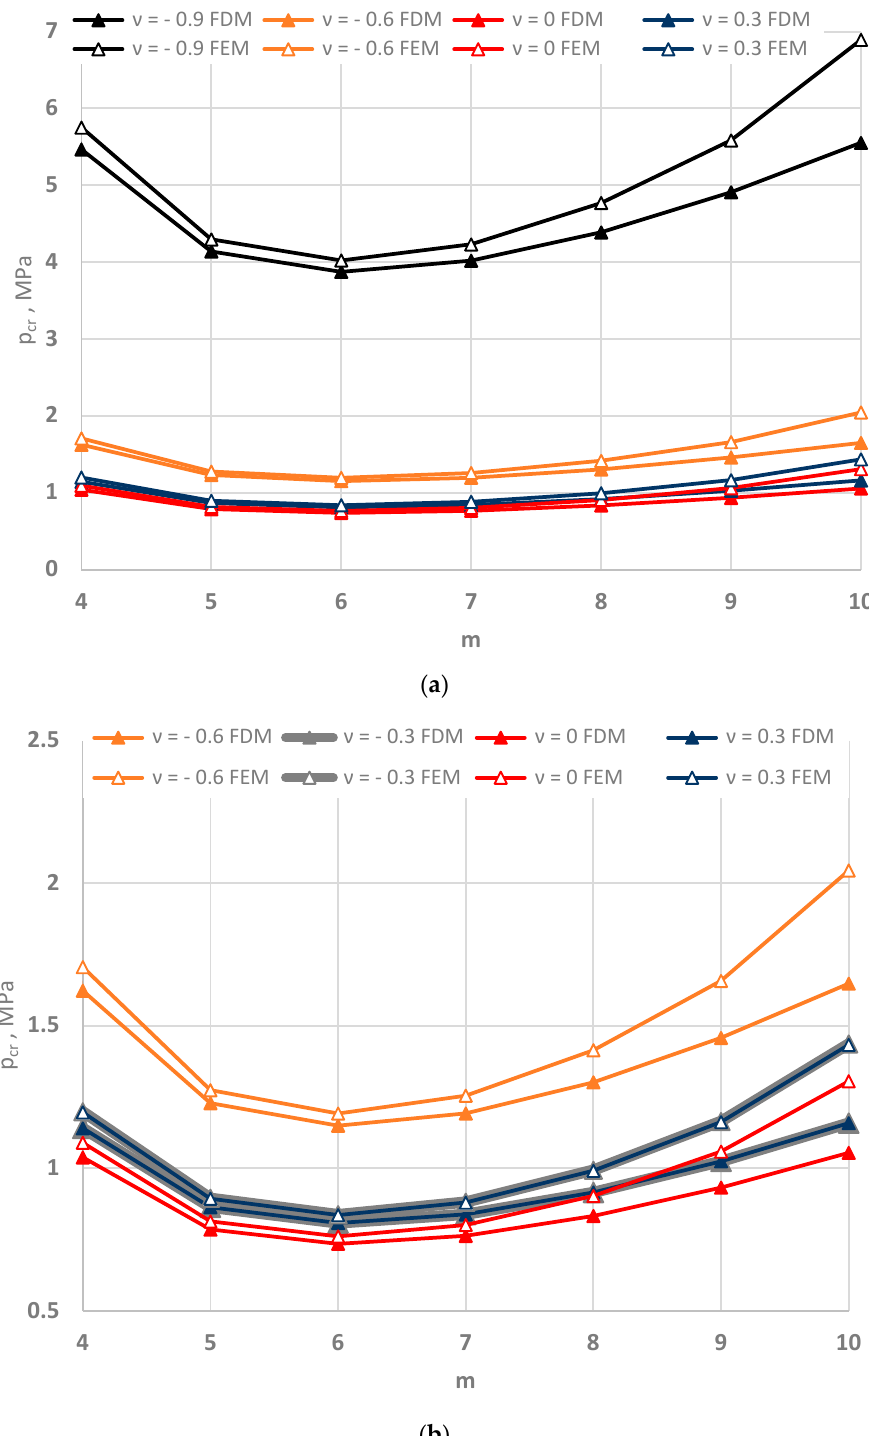
Figure 7. Critical static load p cr distribution versus mode m for the FDM and FEM homogeneous plate models radially stretched on the inner edge: for values of Poisson’s ratio ν = − 0.9, − 0.6 and ν = 0, 0.3 ( a ), for values of Poisson’s ratio − 0.6 ≤ ν ≤ 0.3 ( b ). Figure 8 shows exemplary modes of the homogeneous plate with auxetic facings with Poisson’s ratio ν = − 0.3 when radially stretched on the inner edge.